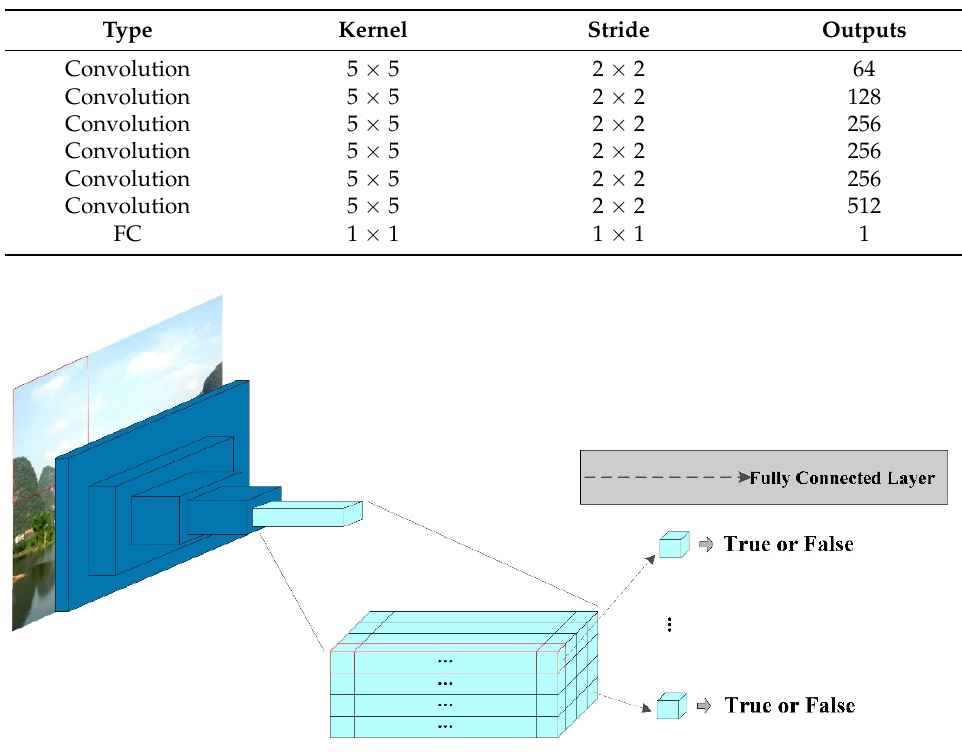
Figure 6. Illustration of